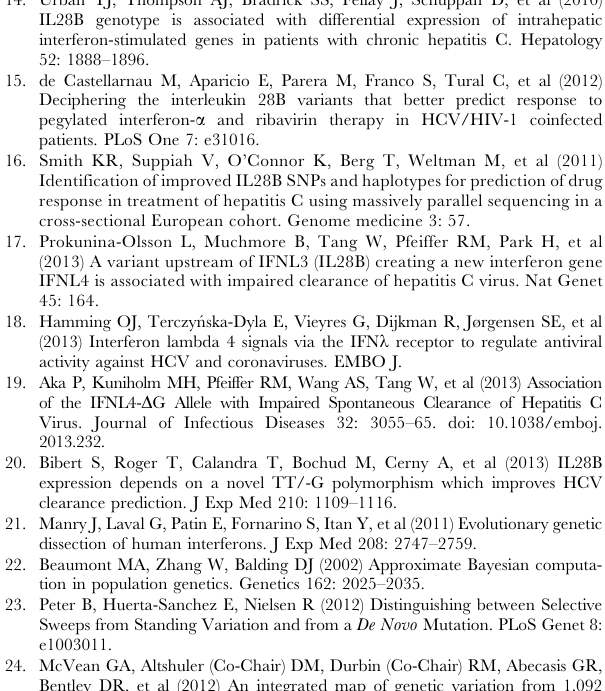
Table S1 PAML results using either (a) all species or (b) only primates. Table S2 Frequency of rs368234815 TT allele in the 1000 Genomes dataset and the subset of 50 unrelated individuals per population used for analyses. Table S3 F ST values and corresponding empirical P-values for rs368234815 using different background populations: (a) ASW, (b) LWK (c) GBR, and (d) in the continental comparison. Table (e) shows the empirical P-value of F ST for rs368234815 based on genome-wide SNPs with lowest frequency in YRI (compared to ASW and LWK).